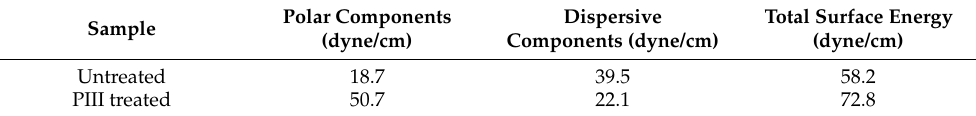
Table 7. Total surface energy, polar, and dispersive components in PIII treated UHMWPE [118].